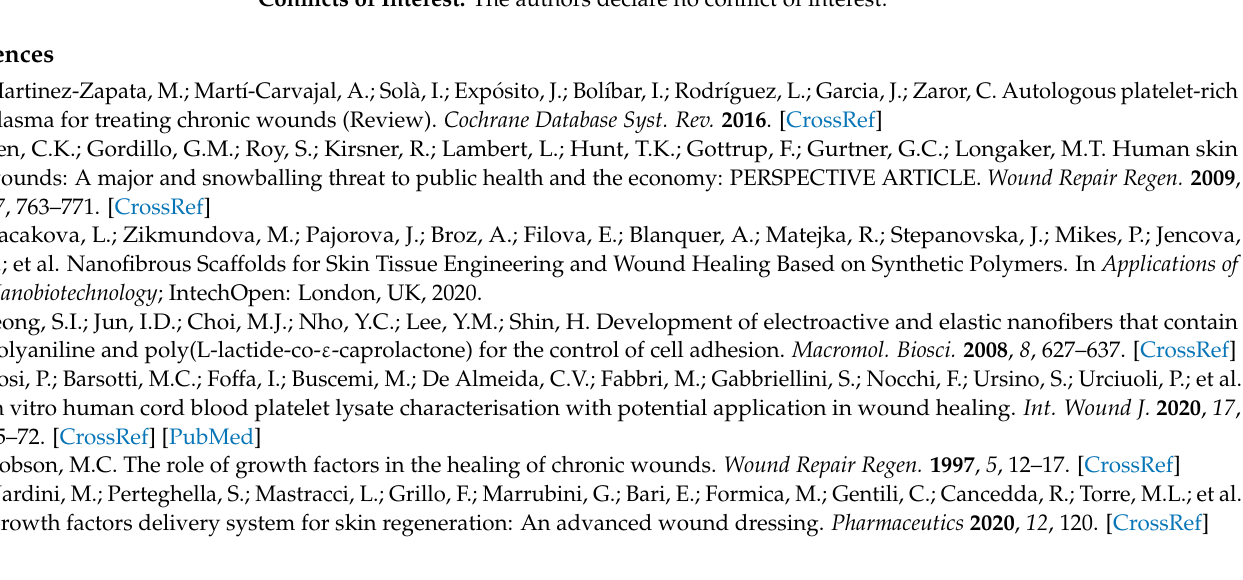
(PCL), Figure S4: Graph of the measured values of fiber diameter from three independent series: cumulative PLCL/PCL blend, pure PCL and pure PLCL, Figure S5: FTIR analysis of the pure PCL, pure PLCL and spectra of PLCL/PCL blend from three separately electrospun